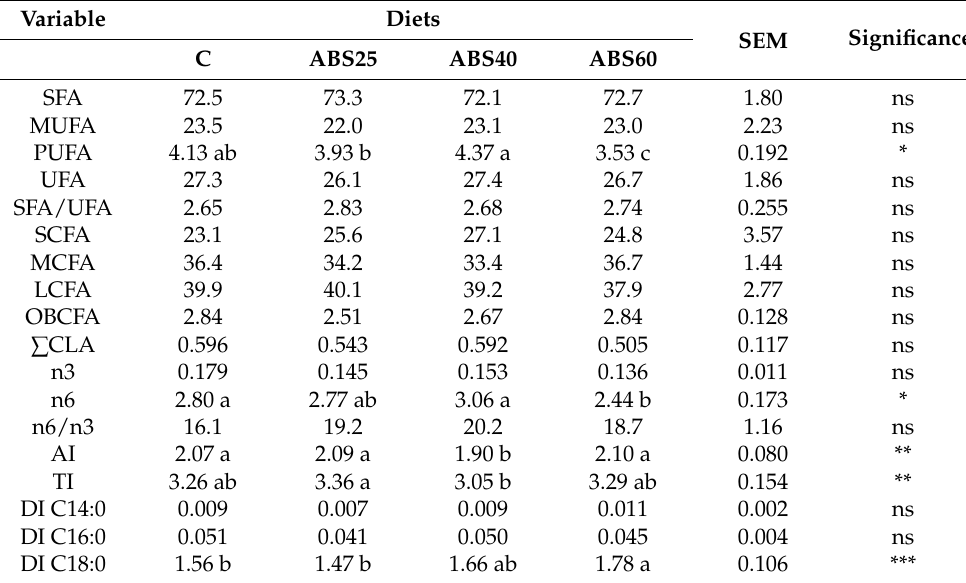
Table 5. Grouped fatty acids (g/100 g total fatty acids) and indices related to cardiovascular health and desaturation activity in milk according to the effects considered.